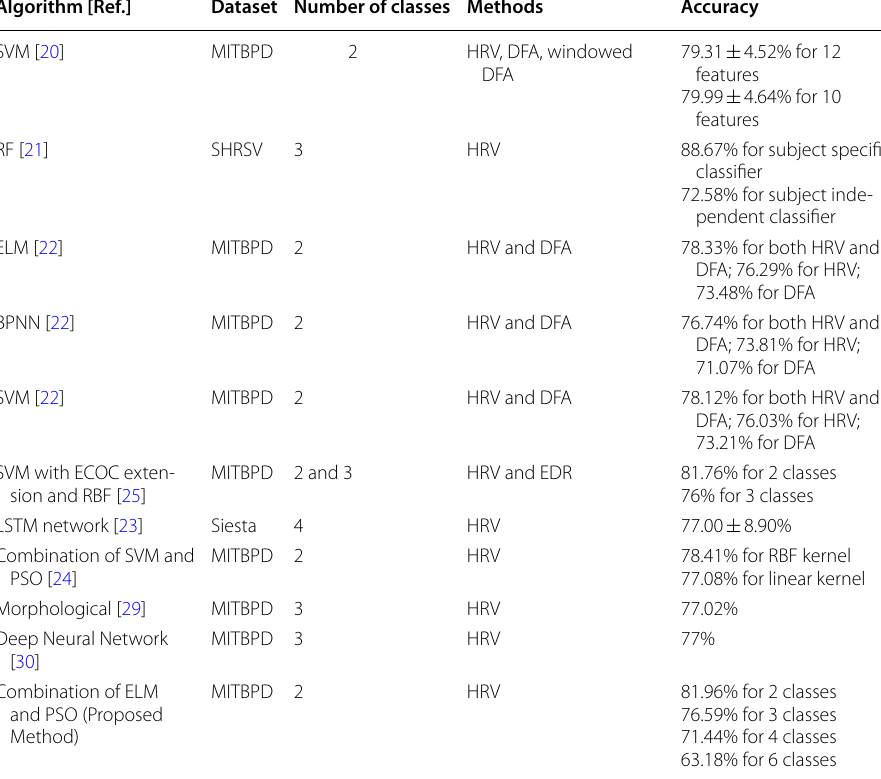
Table 1 Summary of related works on sleep stage classifications using ECG Algorithm